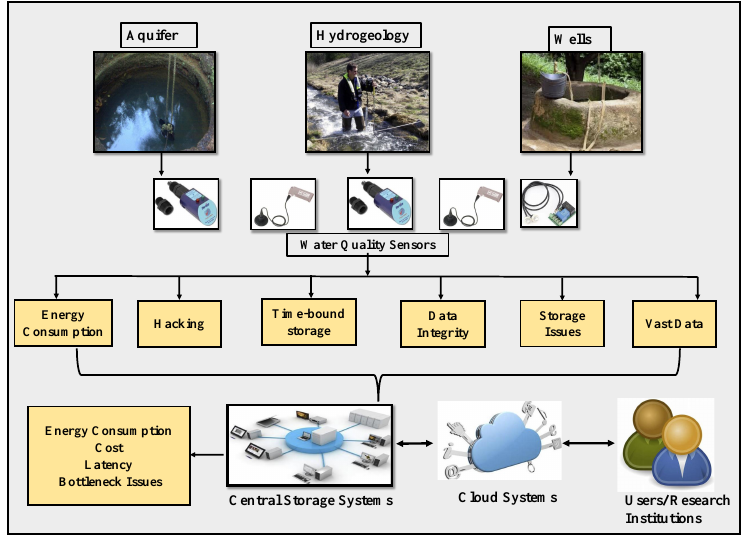
Figure 2. Current IoAT, cloud and central system